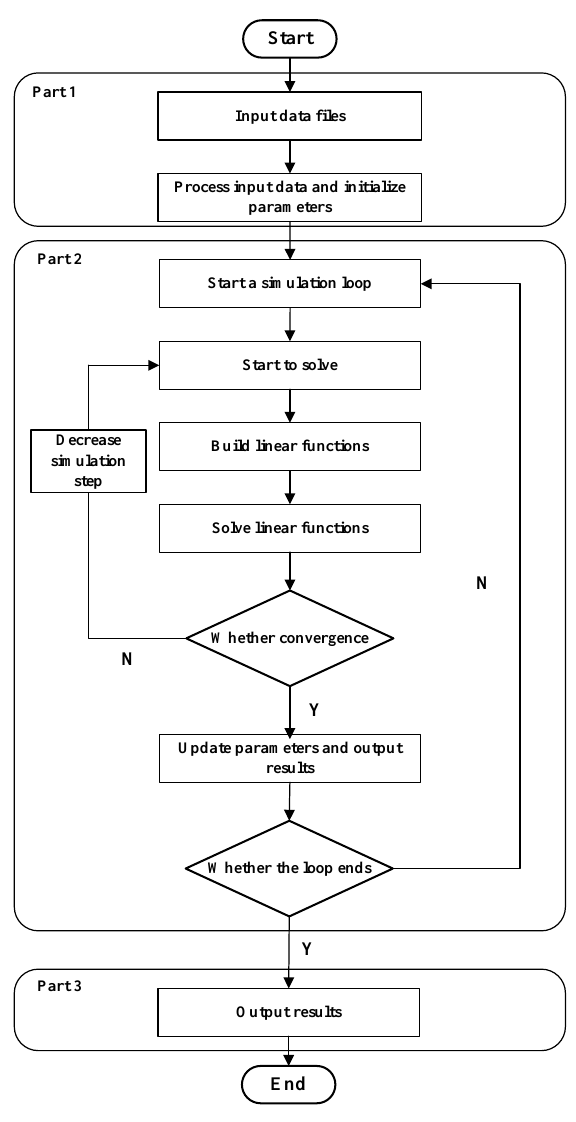
Figure 1. The flowchat of reservoir